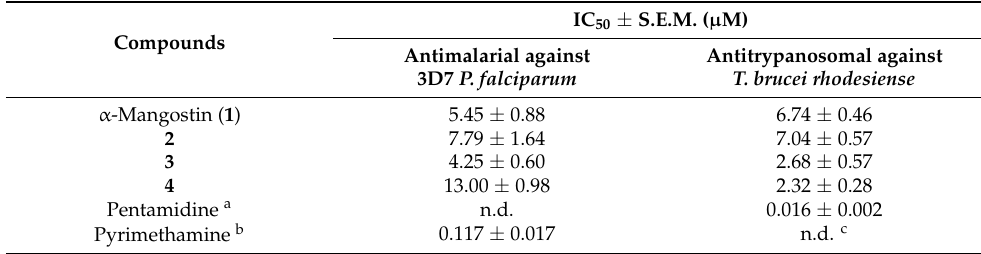
Table 4. Effective half-maximal inhibitory concentrations (IC 50 ) of α -mangostin ( 1 ) and N -containing α -mangostin analogs ( 2 – 4